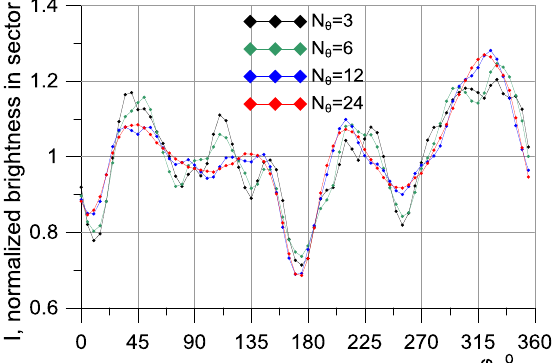
Fig. 6. Angular profiles averaged over different number of samples.